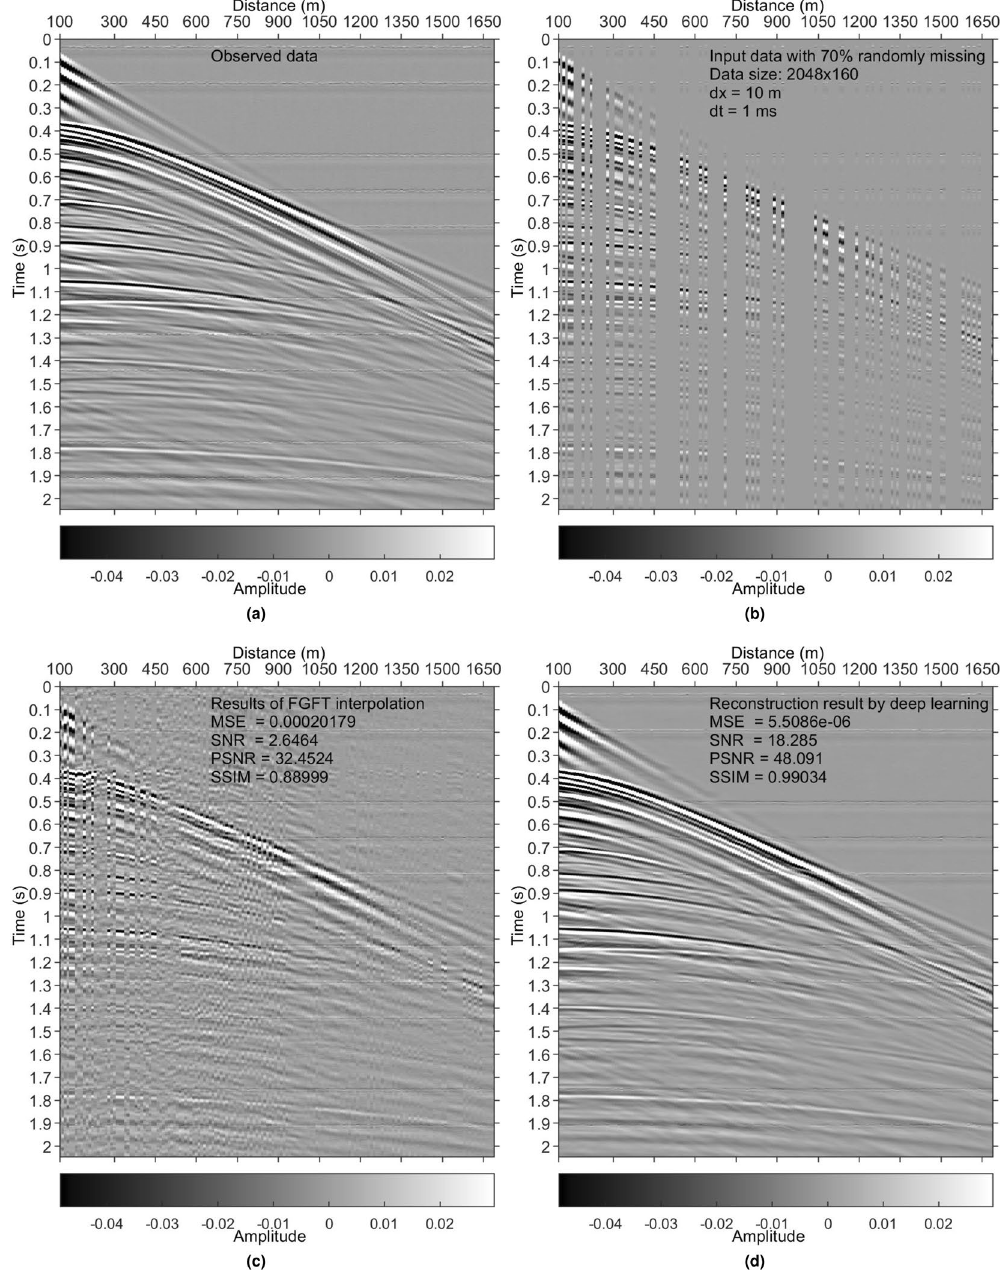
Figure 9. Results on a physical modelling data set 30 . ( a ) Reference data. ( b ) Irregularly sampled data with 70% missing. ( c ) Interpolated data using a fast-generalized Fourier transform (FGFT) method 23 . ( d ) DL reconstruction